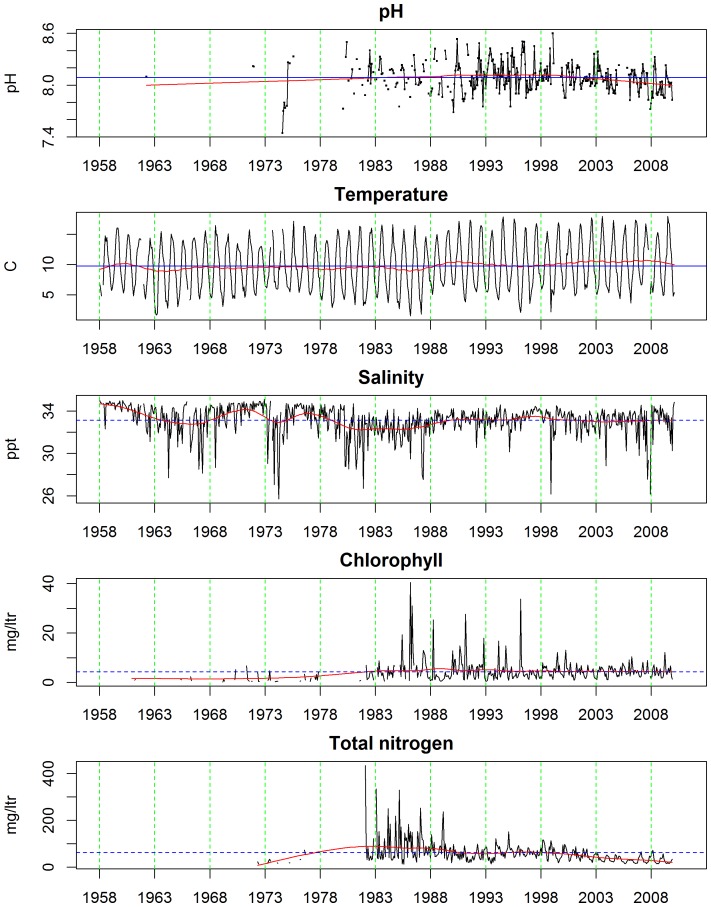
Long-term change in oceanographic variables between 1958 and 2010.Blue dotted line is the average and the red line is the long-term trend estimated using super-smoother.